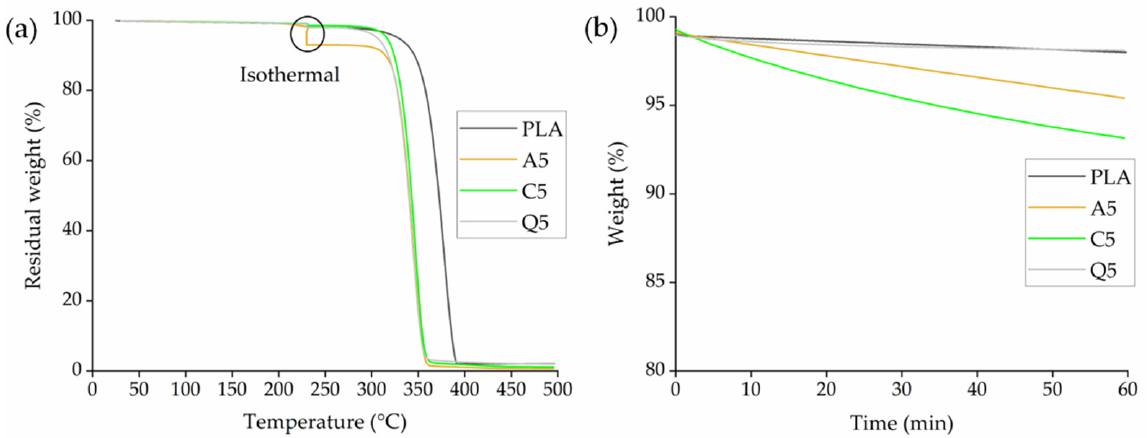
Figure 11. TGA thermogram of PLA and its composites containing 5% ( w / w ) of alizarin (A5), curcumin (C5), or quercetin (Q5) during ( a ) the heating ramp from 25 to 230 °C and ( b ) the isothermal step for 60 min at 230 °C.